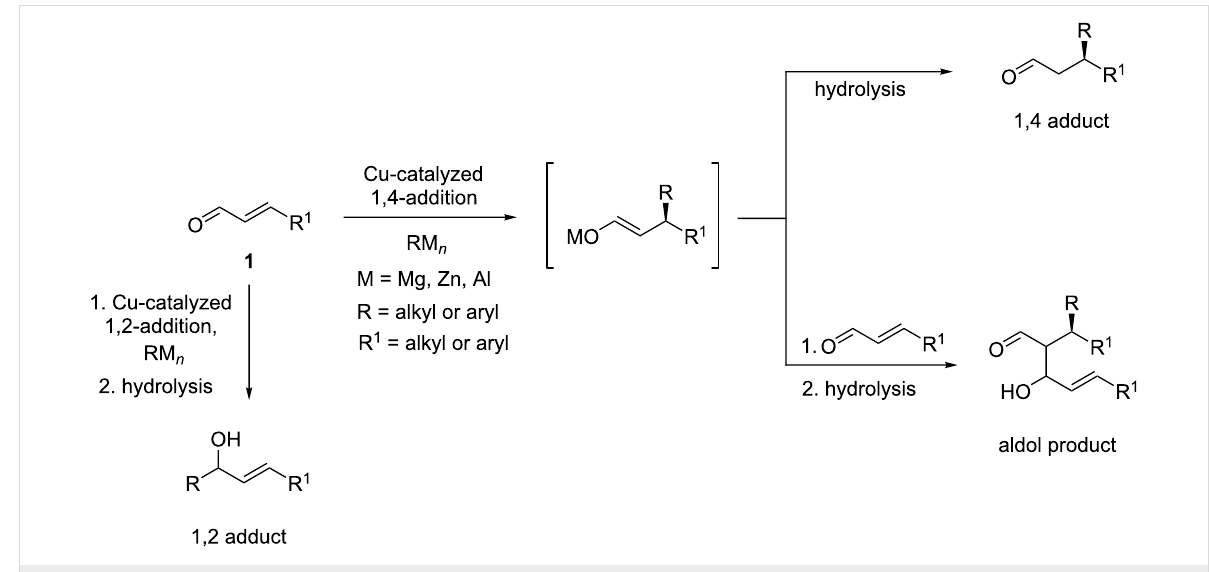
Scheme 1: Competitive side reactions in the Cu ECA of organometallic reagents to α , β -unsaturated